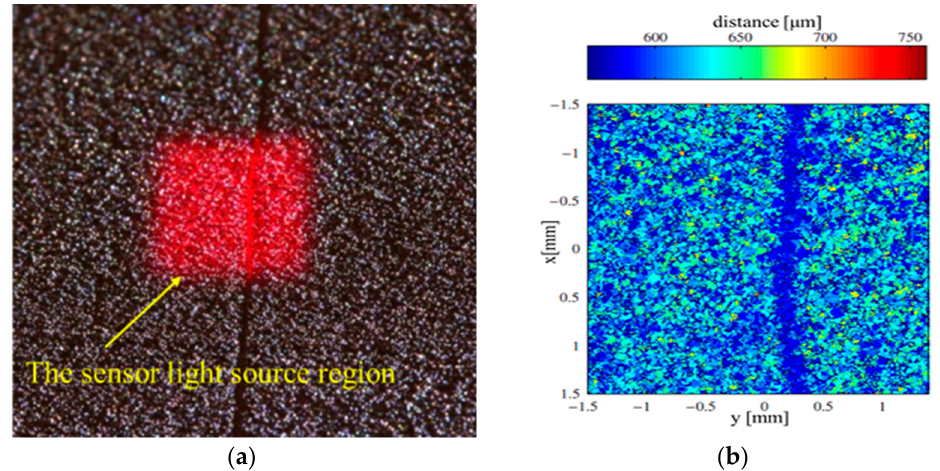
Figure 7. Powder bed inspection using low–coherence interference imaging in SLM. ( a ) Optical mor ‐ phology of powder bed surfaces; ( b ) Profile scanning of powder materials [28]. morphology of powder bed surfaces; ( b ) Profile scanning of powder materials